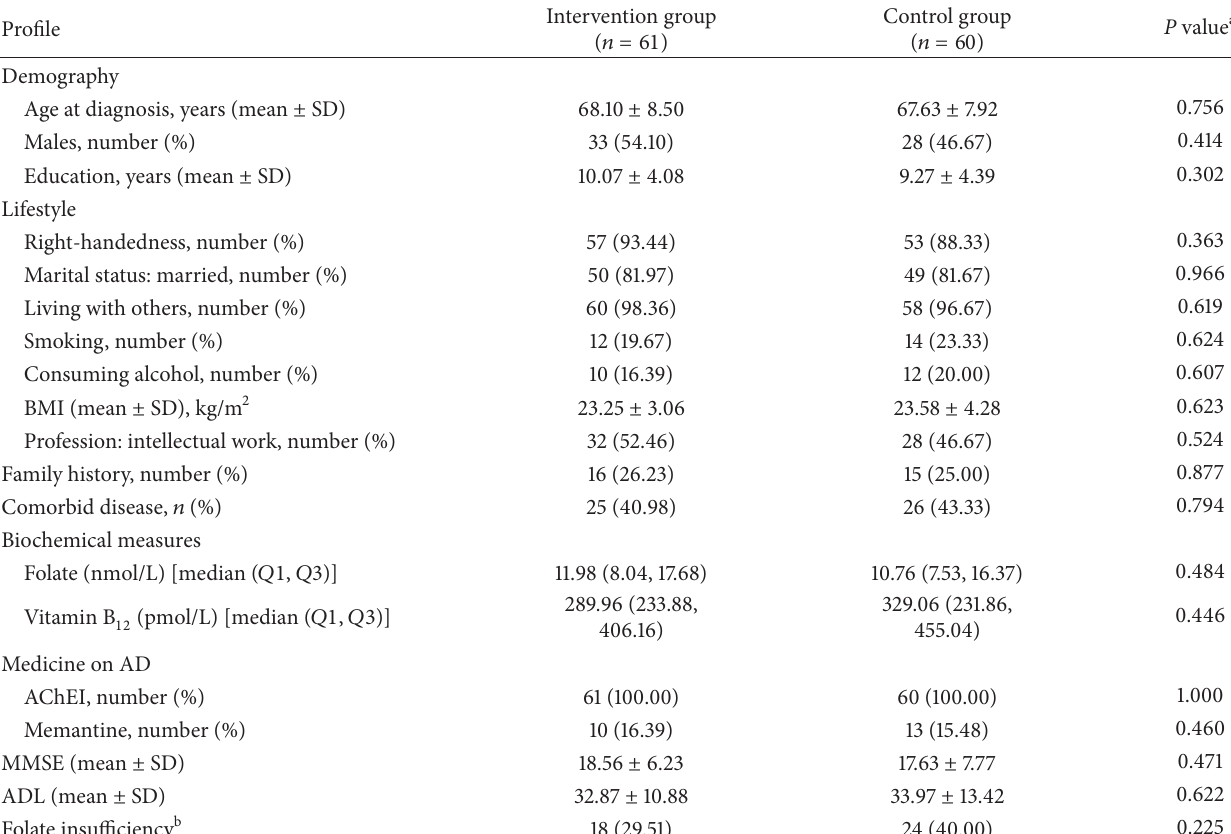
Table 2: Baseline characteristics of the study